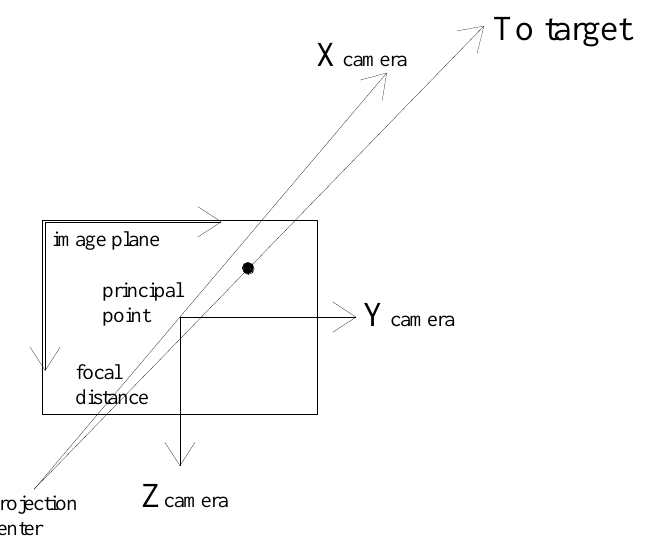
Figure 1. Frontal pinhole camera model (neglecting optical